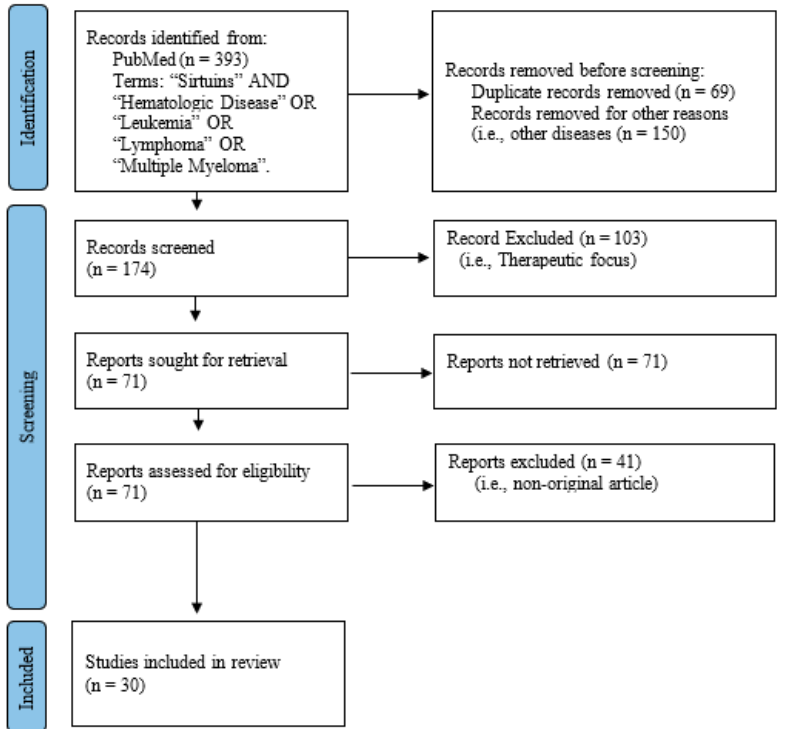
Figure 3. Flowchart of data obtained from the search of PUBMED/Medline records based on the PRISMA methodology.